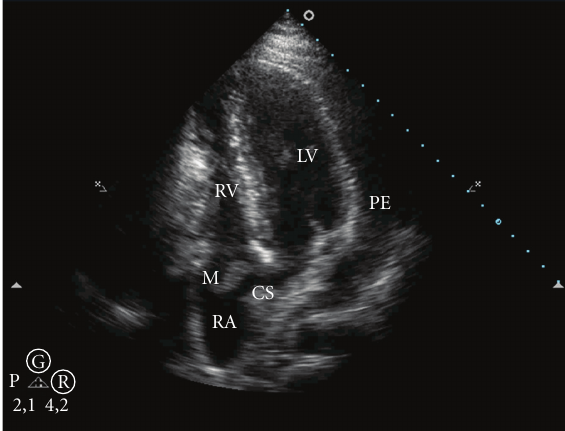
Figure 2: Transthoracic echocardiography: apical four-chamber view showing large pericardial e ff usion and mass in the right atrium at the coronary sinus (RA: right atrium; LV: left ventricle; RV: right ventricle; CS: coronary sinus; PE: Pericardial e ff usion; M: mass).